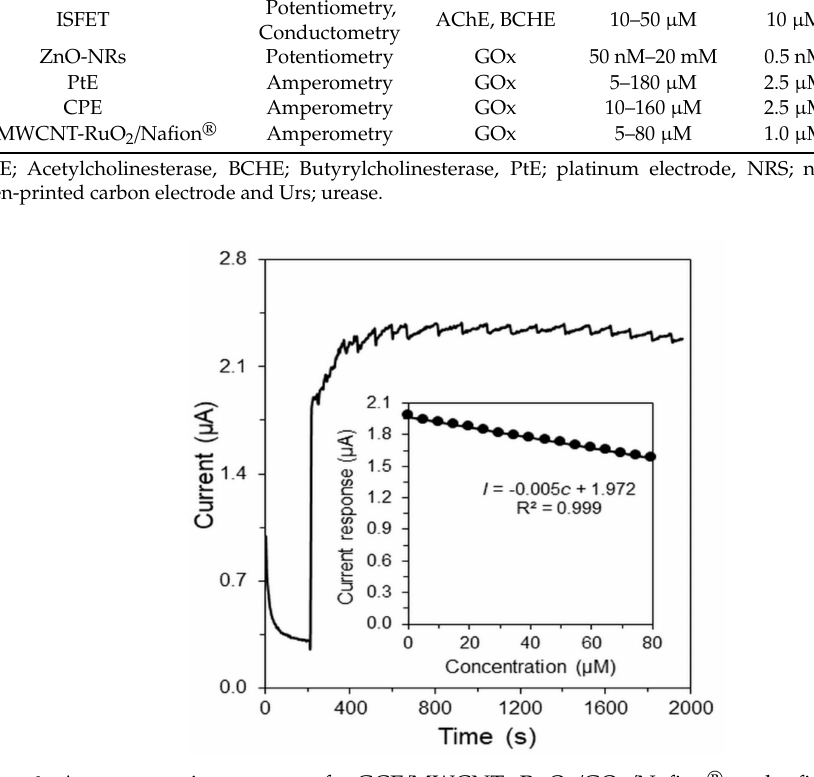
Figure 6. Amperometric response of a GCE / MWCNTs-RuO 2 / GOx / Nafion ® to the first addition of 550 µ M glucose and subsequent additions of 5.0 µ M mercury(II). The measurement was performed in 0.1 M PB of pH 7.0 at potential + 0.4 V and speed of stirring 400